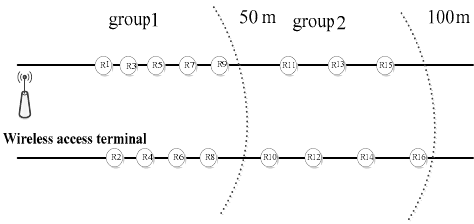
Figure 4. Nodes deployment of group routing protocol.